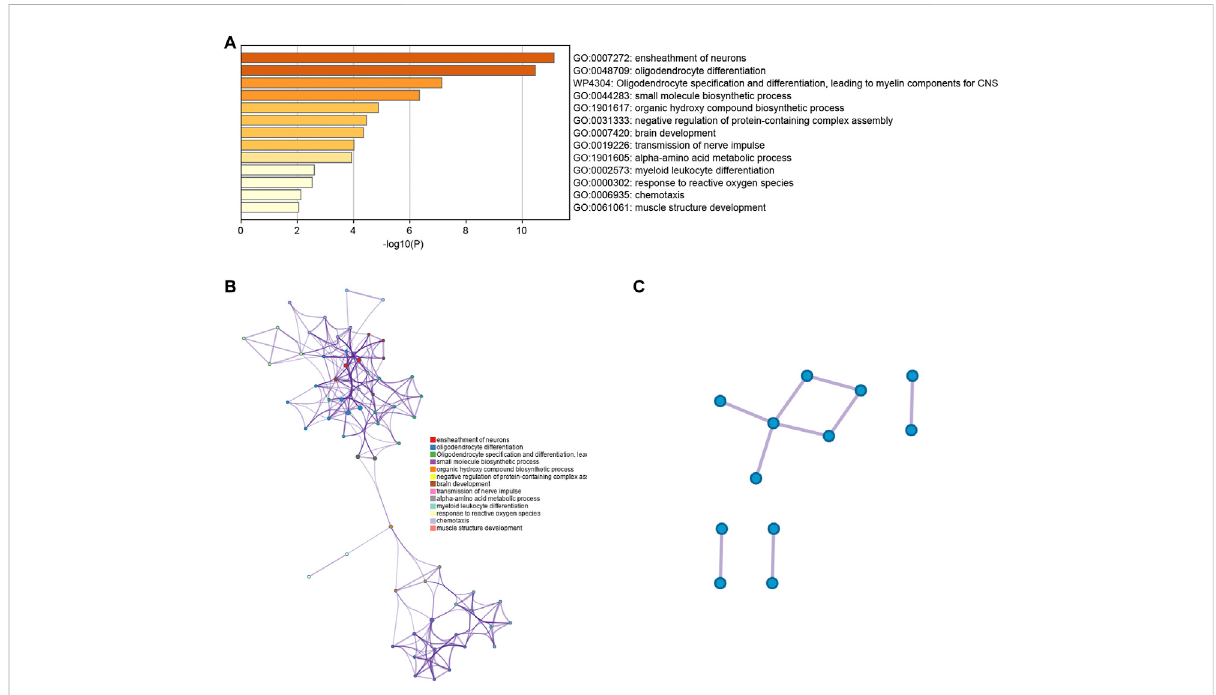
FIGURE 3 (A) Bar graph representing the enriched terms in the gene list, which are shaded according to their p -values. (B) A network of enriched terms, shadedaccordingtocluster-ID,withnodessharingacommoncluster-IDoftensituatedadjacenttoeachother. (C) Thegenelistrevealsanetworkof protein-protein interactions and MCODE